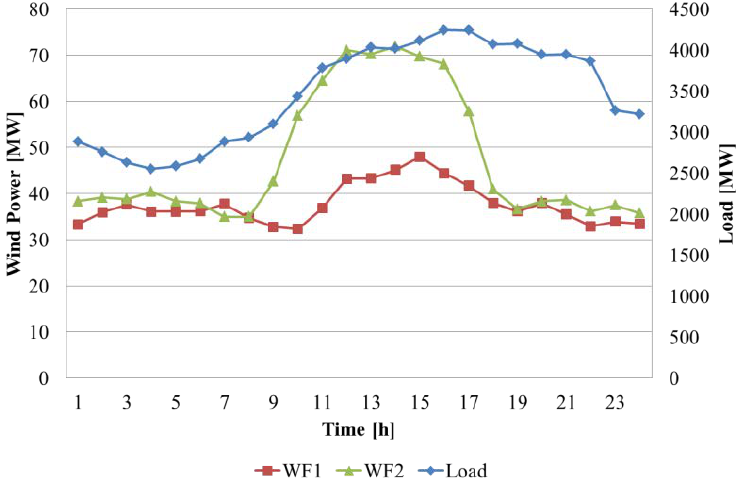
Figure 7. Mean value of hourly load and wind generation